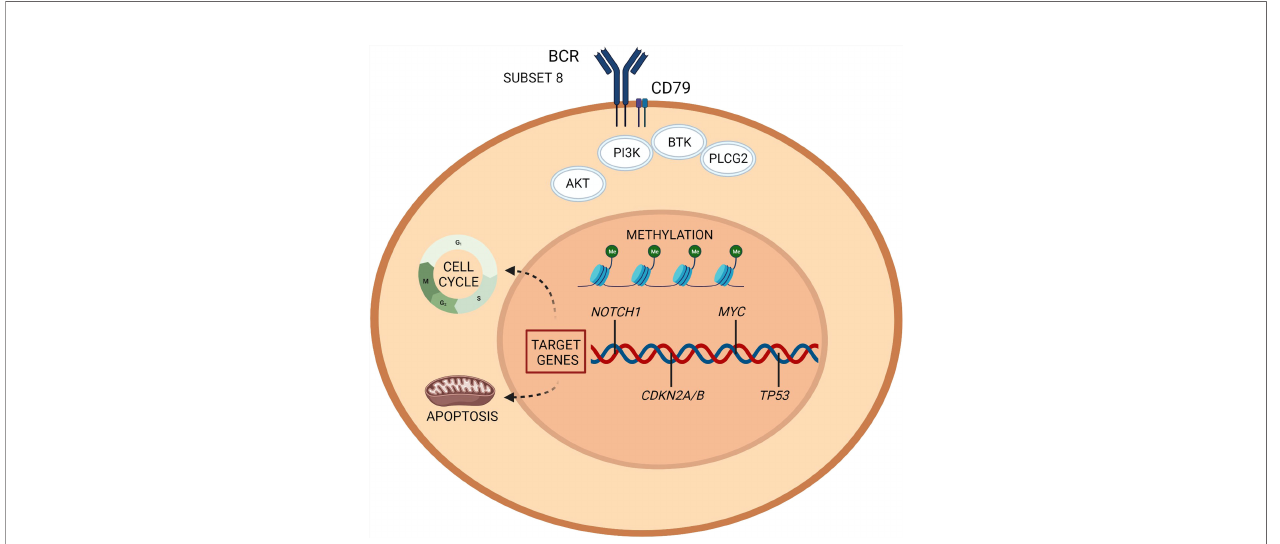
FIGURE 1 | Richter transformation: intrinsic vulnerabilities and targets for treatment. A representation of the molecular pathogenesis of Richter transformation, resulting from a number of epigenetic and genetic lesions occurring in the tumor cell population. Recurrently mutated genes affect DNA repair, B cell receptor, and chromatine modi fi cation. Created with BioRender.com.